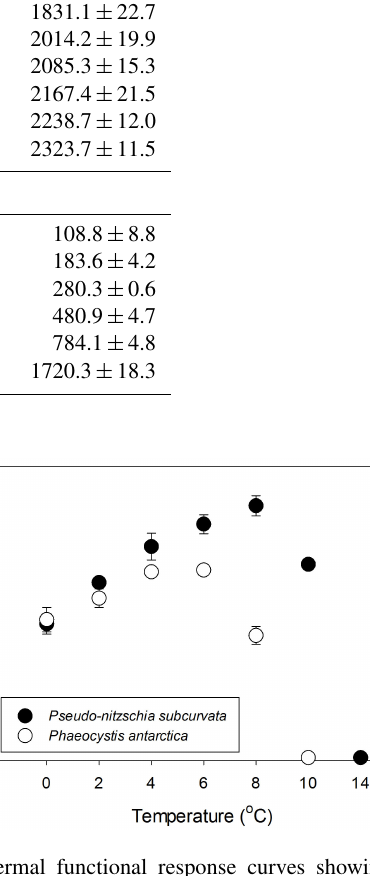
vata stopped growing at 10 and 14 ◦ C, respectively (Fig.